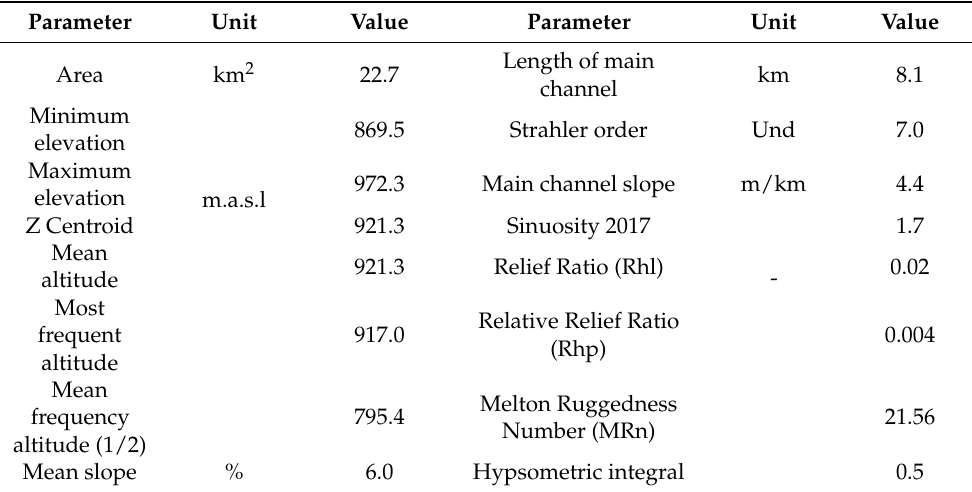
Table 1. Summary of the morphometric parameters calculated.